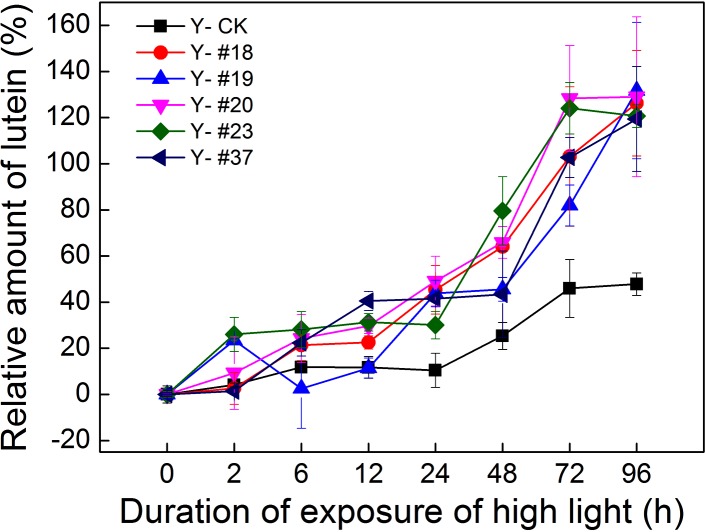
Relative amount of lutein in the progenies and in the control group during HL exposure.The concentration of lutein was measured by HPLC. The five progenies and the control group were grown under HL exposure (300–400 μmol photons m-2 s-1) for 96 h, and each value obtained during HL exposure was compared with that obtained under normal conditions (0 h). n = 3+SD.